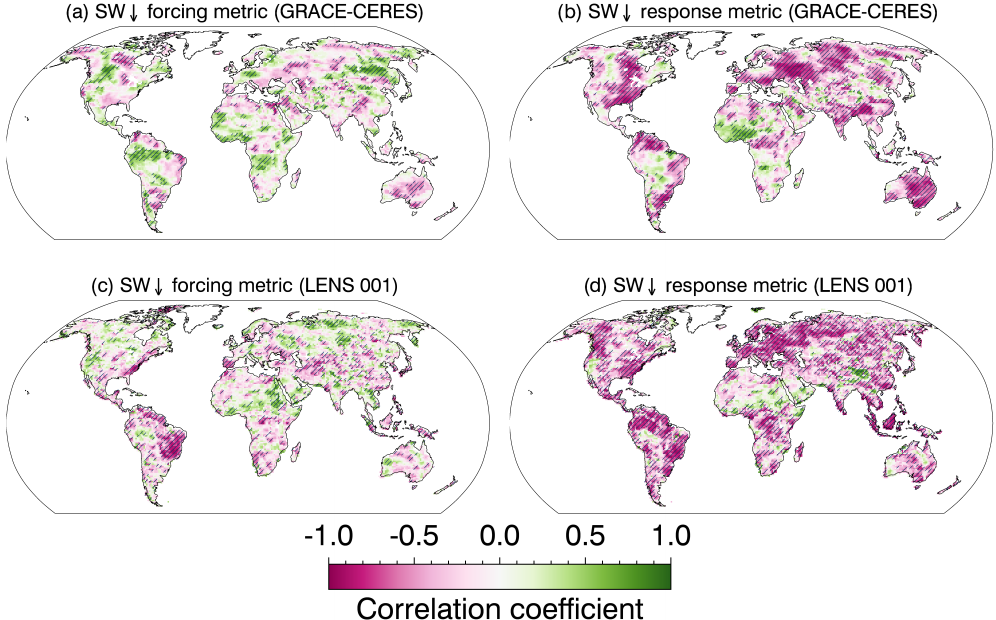
Figure 7. Forcing and response metrics for SW ↓ from GRACE/CERES (a, b) and LENS ensemble member 001 (c, d) . Cross-hatching indicates a correlation coefficient that is statistically significant at p ≤